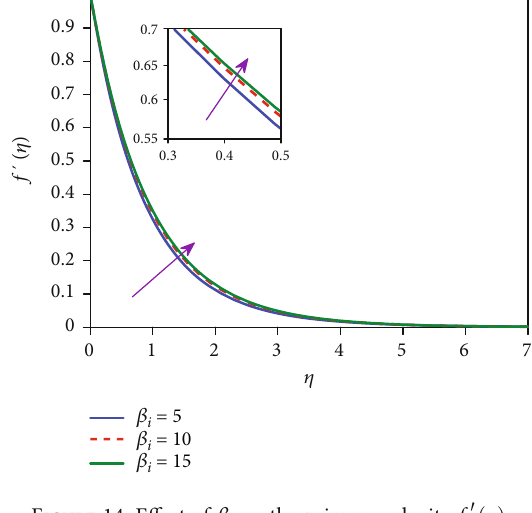
Figure 14: E ff ect of β